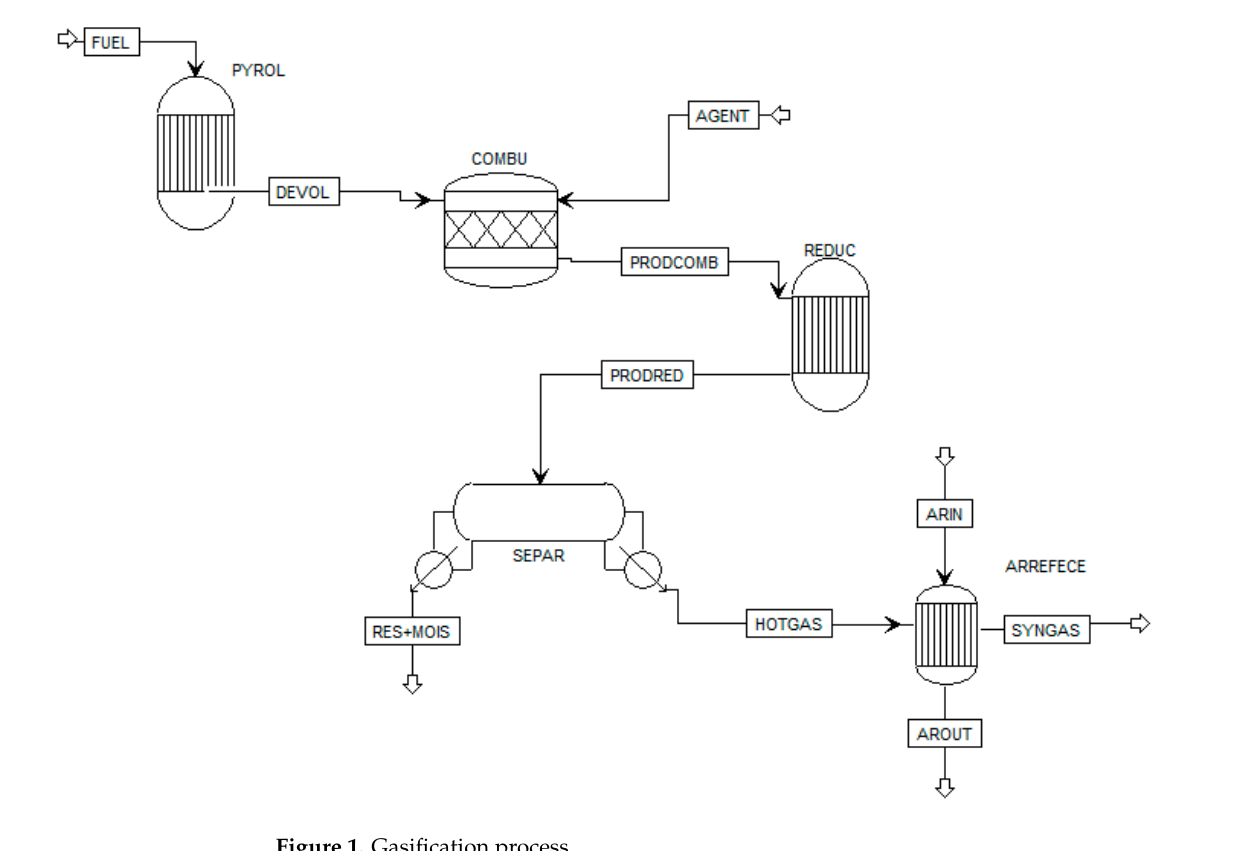
Figure 1. Gasification process. Table 3. Description of units used in the gasification process.